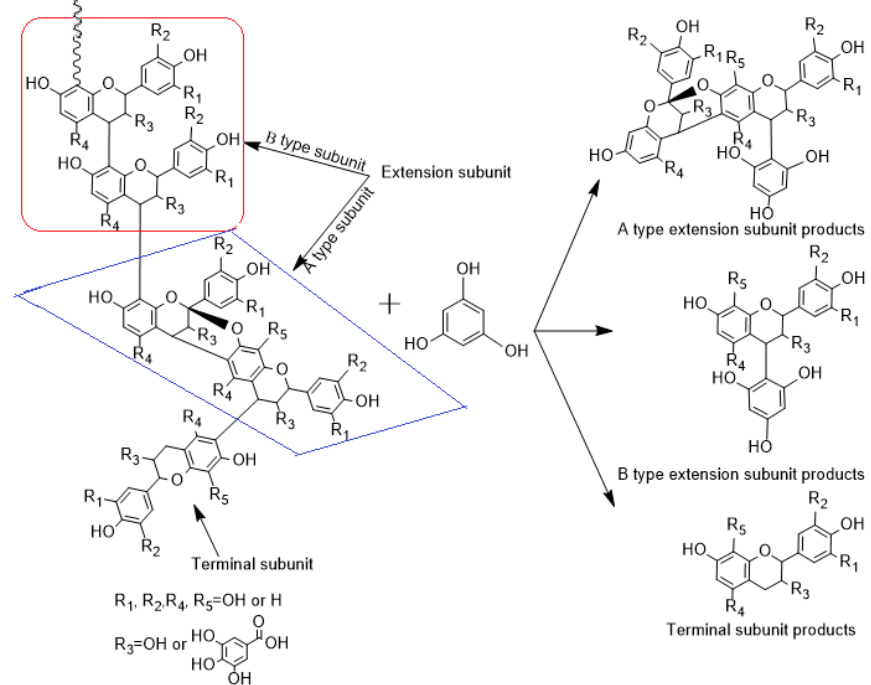
Figure 6. Nucleophilic reaction of condensed tannin and phloroglucol.